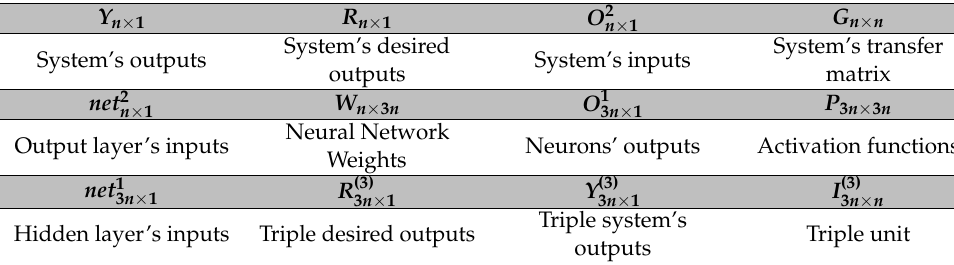
Table 1. Matrices defined for